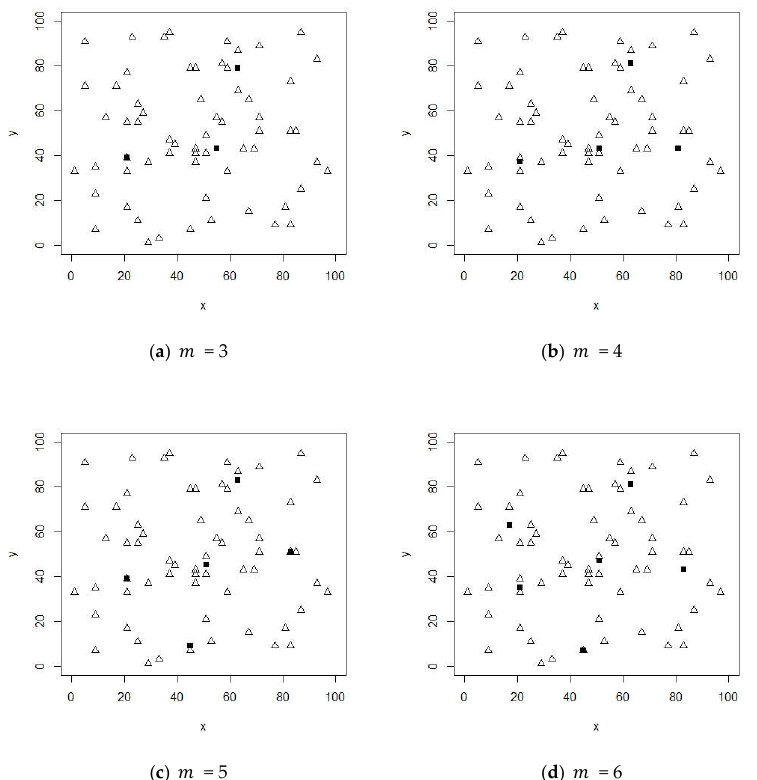
Figure 6. Globally optimal facility locations in the planning area for Instance 27. ( a ) m = 3; ( b ) m = 4; ( c ) m = 5; ( d ) m = 6.